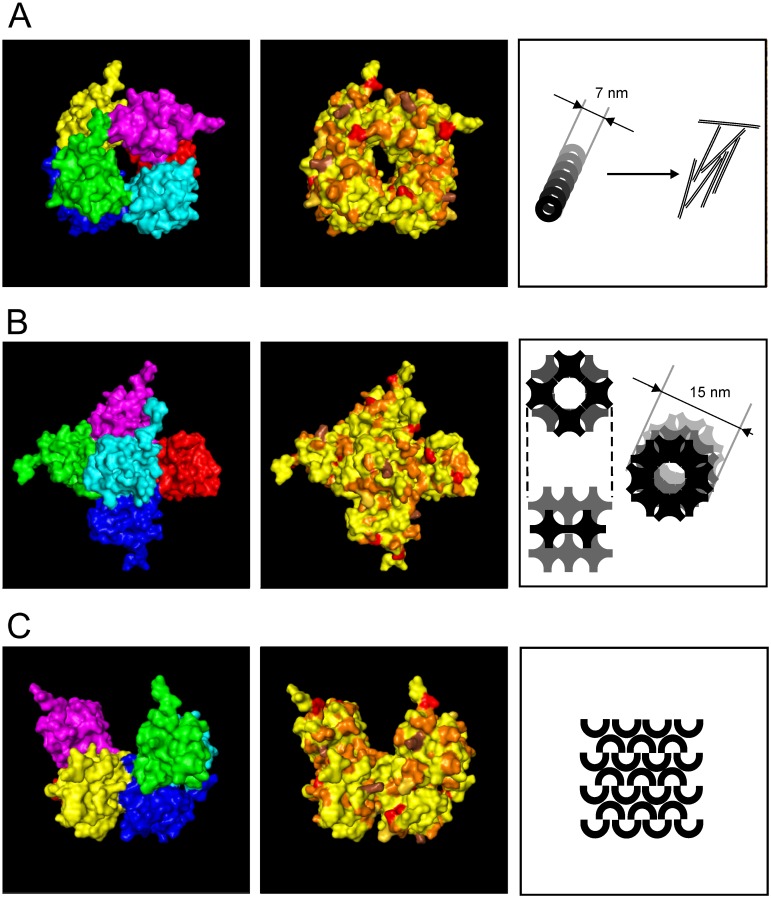
Predictions of possible assembly of six Hyd8 proteins showing the six proteins, amino acids coloured depending on properties and a located/postulated structure.Beside the six proteins in different colours, amino acids coloured depending on properties: yellow—hydrophobic, dark yellow—amphipathic, orange—polar, red—negatively charged, brown—positively charged. (A) A ring structure with 7 nm in diameter similar to HGFI from Grifola frondosa [17], (B) a plus-like structure which results in a 15 nm diameter if four plus structures are combined and (C) packing arrangement to a sheet-like layer such as HFBII from Trichoderma reesei [21].